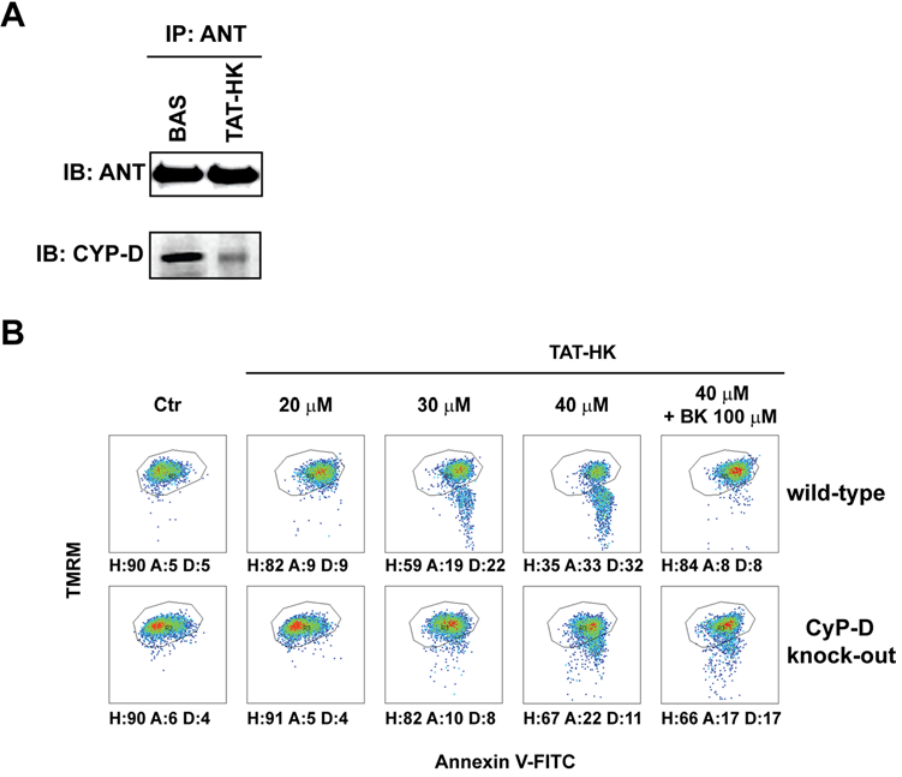
Figure 5. ANT modulates apoptosis triggered by detachment of HK II from mitochondria. (A) Western blot of ANT immunoprecipitation. Co-immunoprecipitation of CyP-D in wild-type mouse fibroblasts is shown either in control conditions or after a 1 hour treatment with TAT-HK. (B) Output of multiparametric FACS analyses show apoptosis induction in fibroblasts obtained either from wild-type mice (upper row) or from CyP-D knock-out animals (lower row). Cells were exposed for 2 hours to the stated concentrations of TAT-HK with or without a 3 hour pre-incubation with bongkrekate (BK, 100 m M). Diagrams and percentages of the different cell populations are indicated as in Fig. 1B. All reported measures in the Figure are representative of at least four